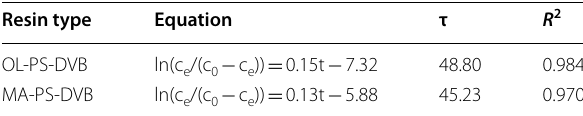
Table 5 Yoon‑Nelson model fitting results of OL‑PS‑DVB